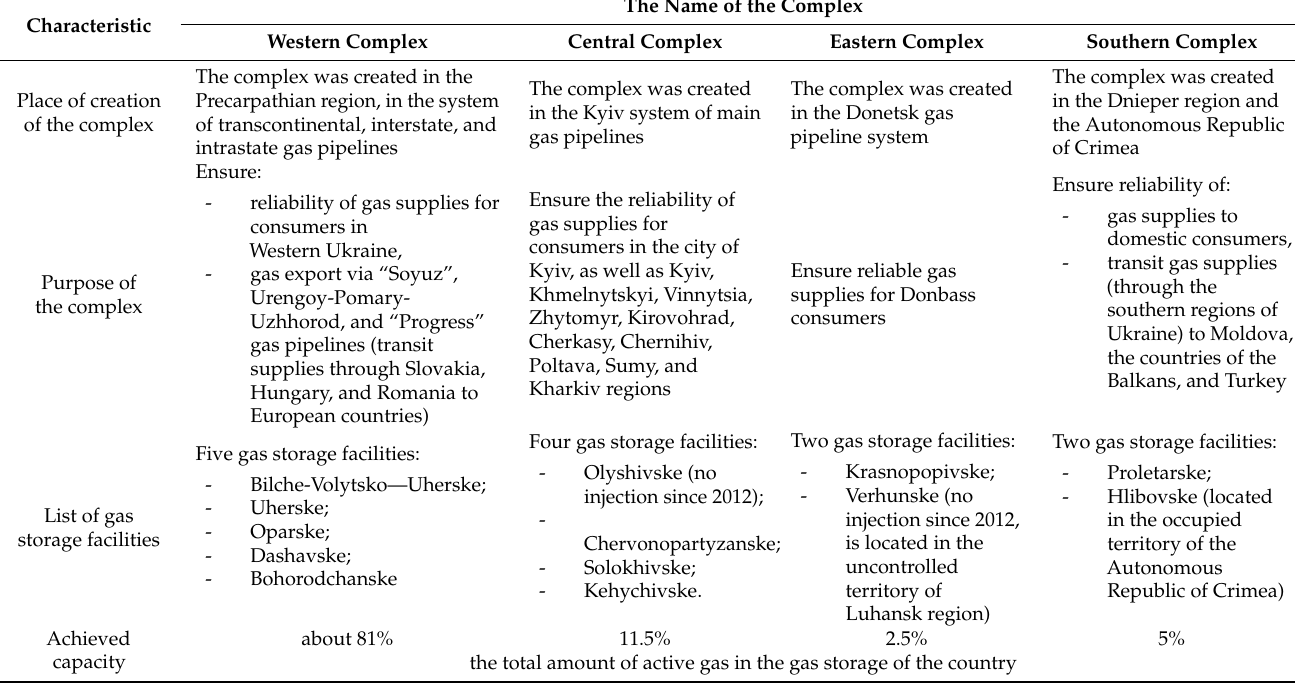
Table 2. Characteristics of underground gas storage complexes in